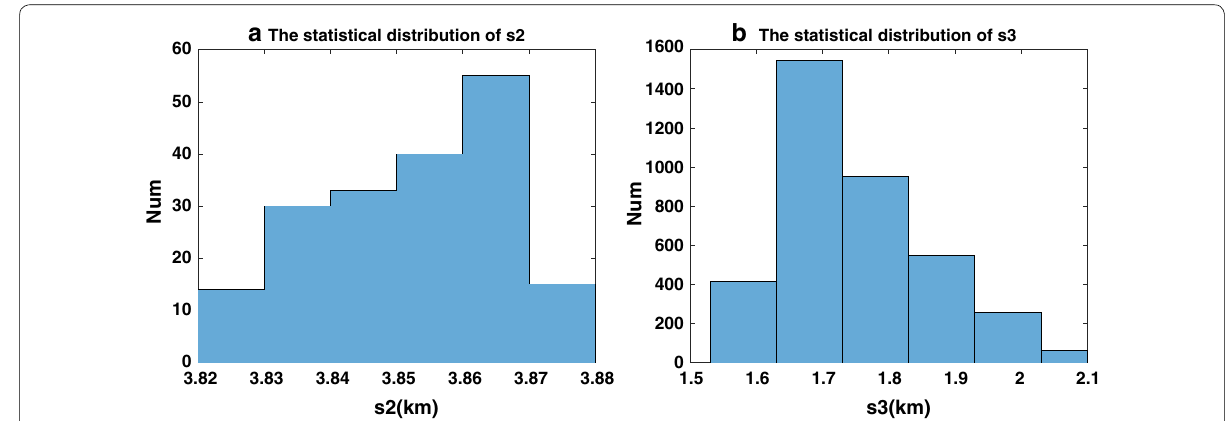
Fig. 2 a The statistical distribution of minimum IPP moving distances between HKPC and KYC1 for the ionosphere height on July 7, 2017. b The statistical distribution of IPP moving distances received by HKQT from PRN14 on July 7,